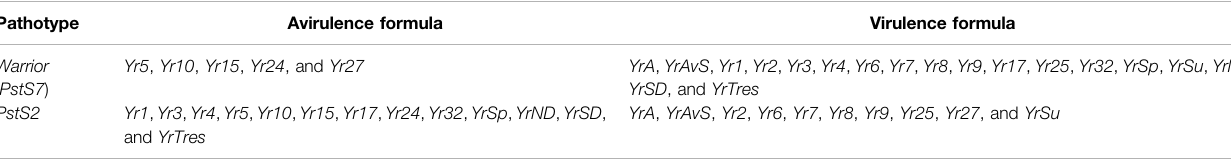
TABLE 1 | Virulence/avirulence formula for the PstS2 and Warrior pathotypes of Pst .